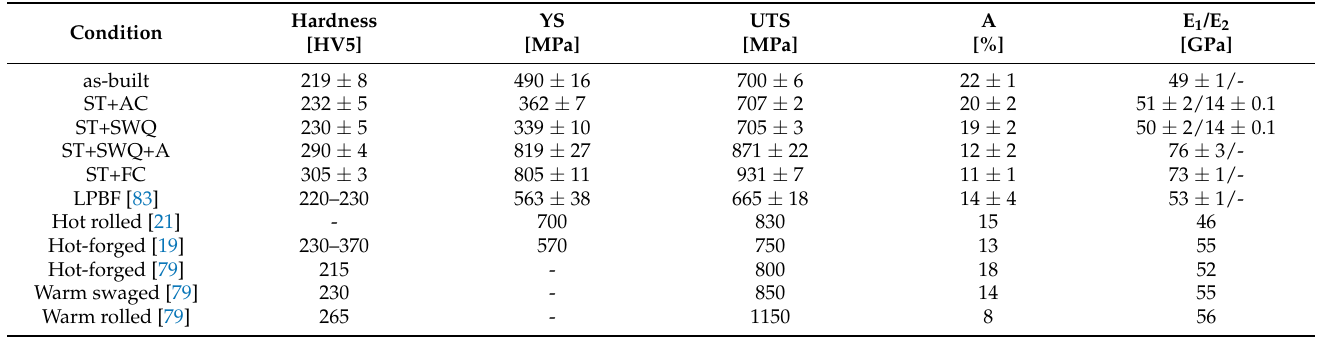
Table 3. Comparison of average mechanical properties, including the hardness and monotonic tensile properties, of the as-built and heat-treated Ti2448, as well as literature values including conventional processing methods: yield strength YS, ultimate tensile strength UTS, fracture elongation A, and Young’s Moduli E 1 and E 2